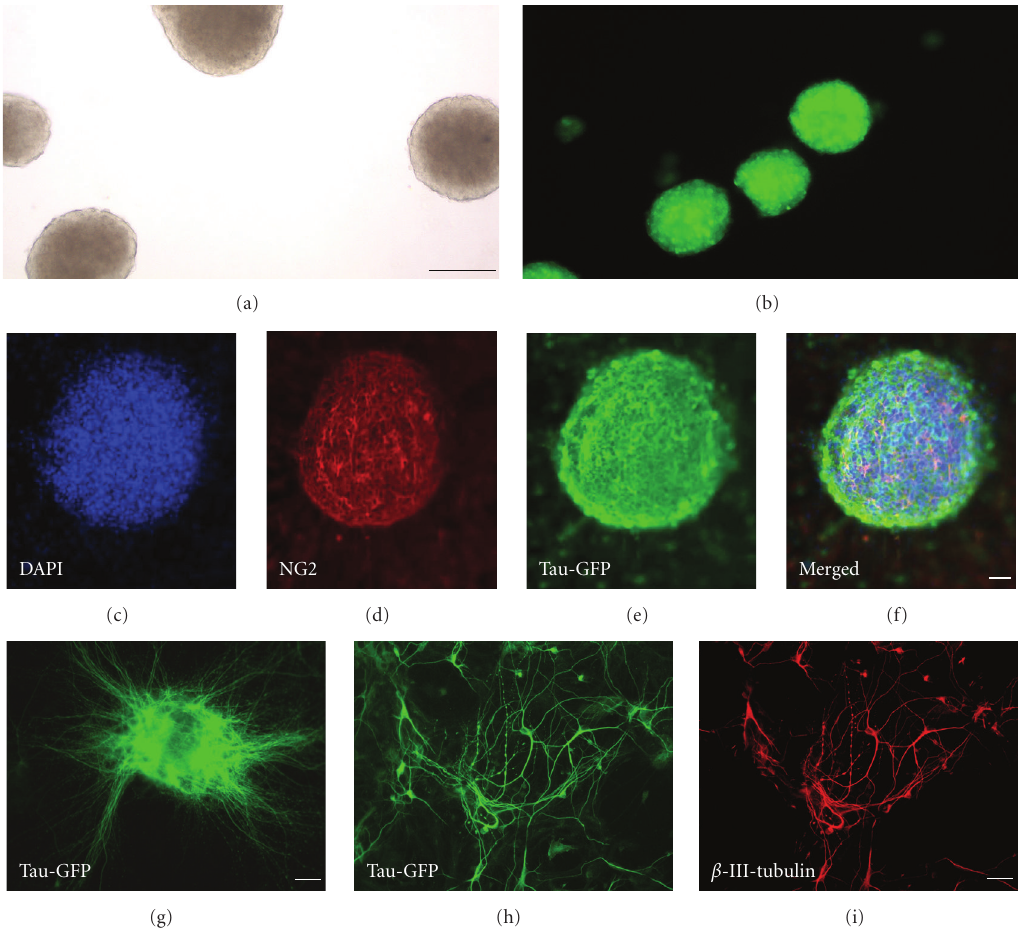
Figure 1: Analysis of neurosphere growth and di ff erentiation in vitro. (a) Low power view (bright field) of a neurosphere culture. Many cortex-derived neurospheres had developed after 7 days in vitro. Scale bar = 50 μ m. (b) Neurospheres expressing a Tau-GFP fusion protein from the cortex of Tau-GFP transgenic mice. (c) DAPI staining of a neurosphere culture. (d) Within the cultured neurospheres, NG2 positive cells (red) were typically located in the center of the rosettes. (e) Tau-GFP expression was present throughout the neurospheres. (f) Merged image between DAPI, Tau-GFP, and NG2 showing the central location of NG2 positive cells within the neurosphere. Scale bar = 20 μ m. (g) One week after transfer to poly-D-lysine-coated dishes, Tau-GFP-positive neurosphere-derived cells had attached and extended processes. Scale bar = 20 μ m. (h) Network of cellular processes from neurosphere-derived cells as seen with Tau-GFP expression. (i) Staining with the neuronal marker β -III-tubulin (H) confirms the neuronal di ff erentiation of many neurosphere-derived cells. Scale bar = 50 μ